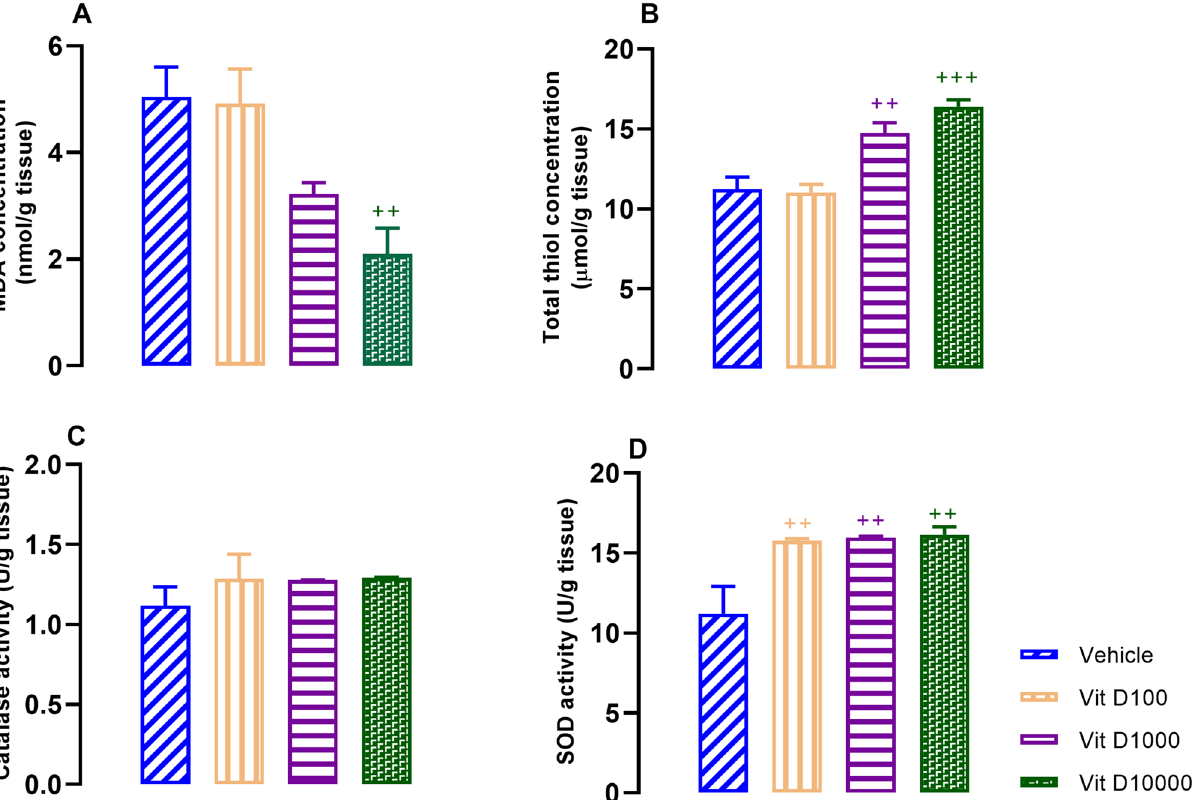
Figure 6. Hippocampal concentrations of MDA ( A ), thiol content ( B ) and activities of catalase ( C ) and SOD ( D ) in Vit D groups. Data are presented as mean ± SEM, n = 10. + + P < 0.01 and + + + P < 0.001 versus vehicle group.